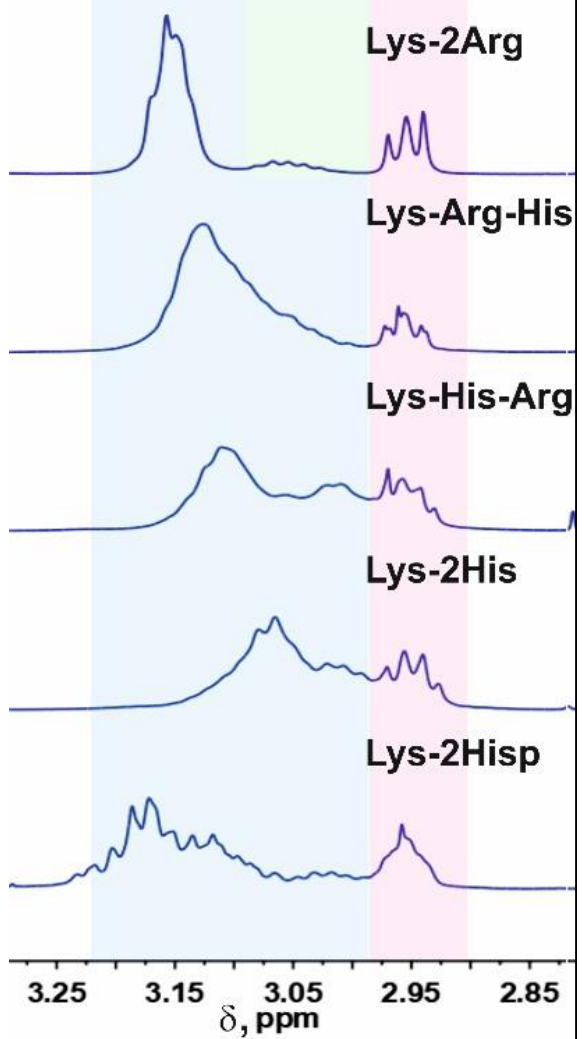
Figure 7. Comparison of 1 H NMR spectra of different peptide dendrimers in the region of signals from inner CH 2 -(N) (green), side and inner (blue) and terminal (red) groups at a temperature of 298 K.